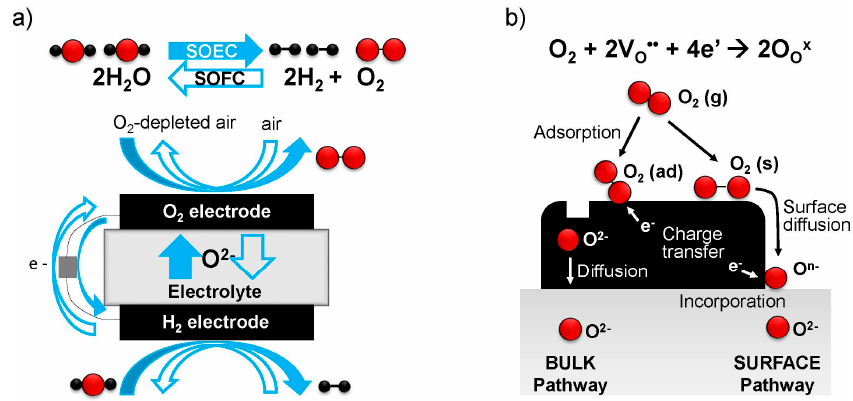
Figure 1. ( a ) Schematic of reversible solid oxide fuel/electrolysis cell; ( b ) two possible oxygen incorporation and reduction pathways in the oxygen electrode (SOFC mode).